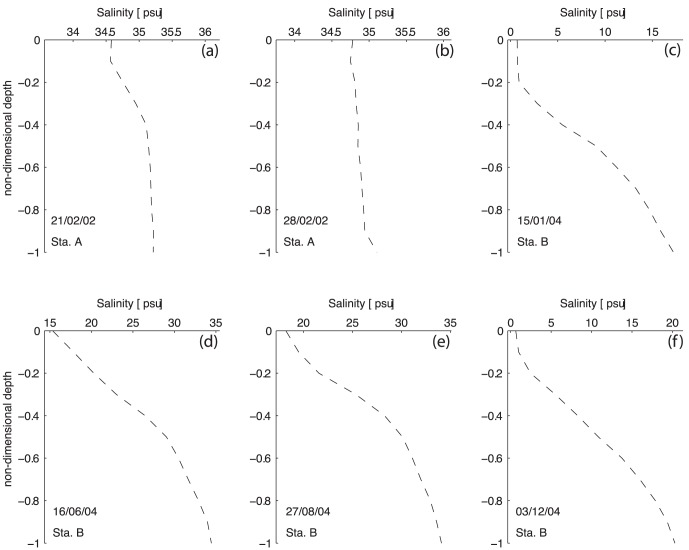
Profiles of non-tidal salinity at stations A and B.